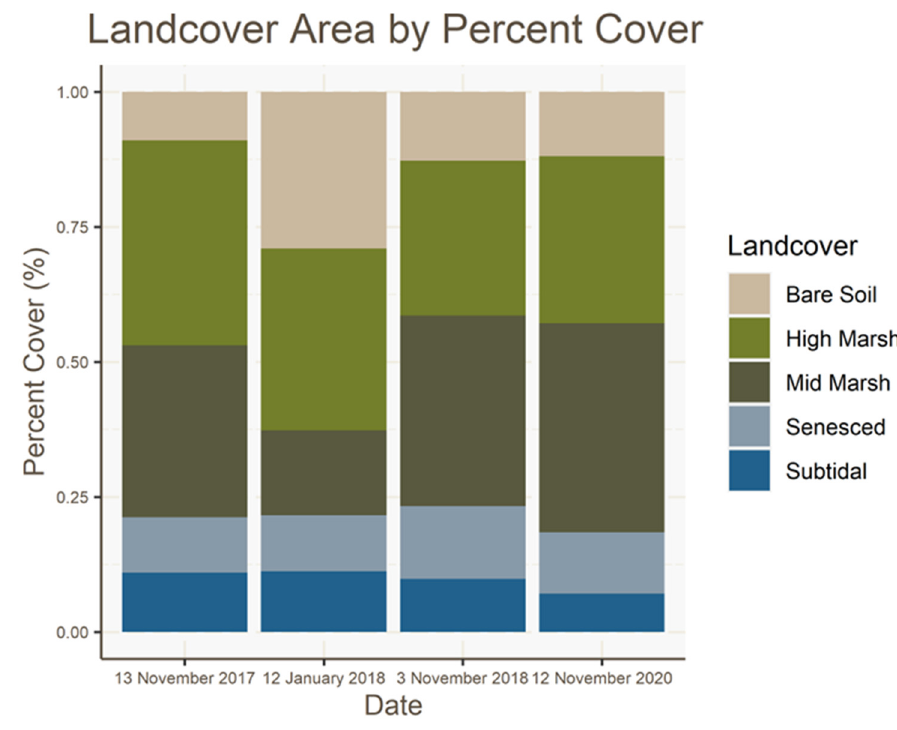
Figure 5. Percent cover for each landcover class in CSMR stacked by date.